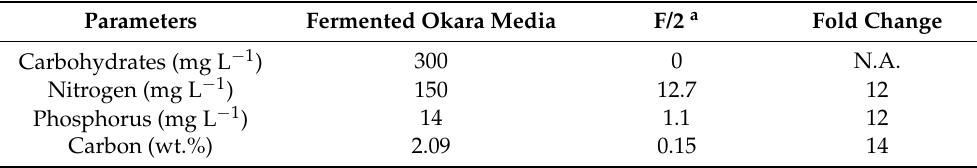
Table 1. Key nutrient composition of fermented okara media and F/2 media.